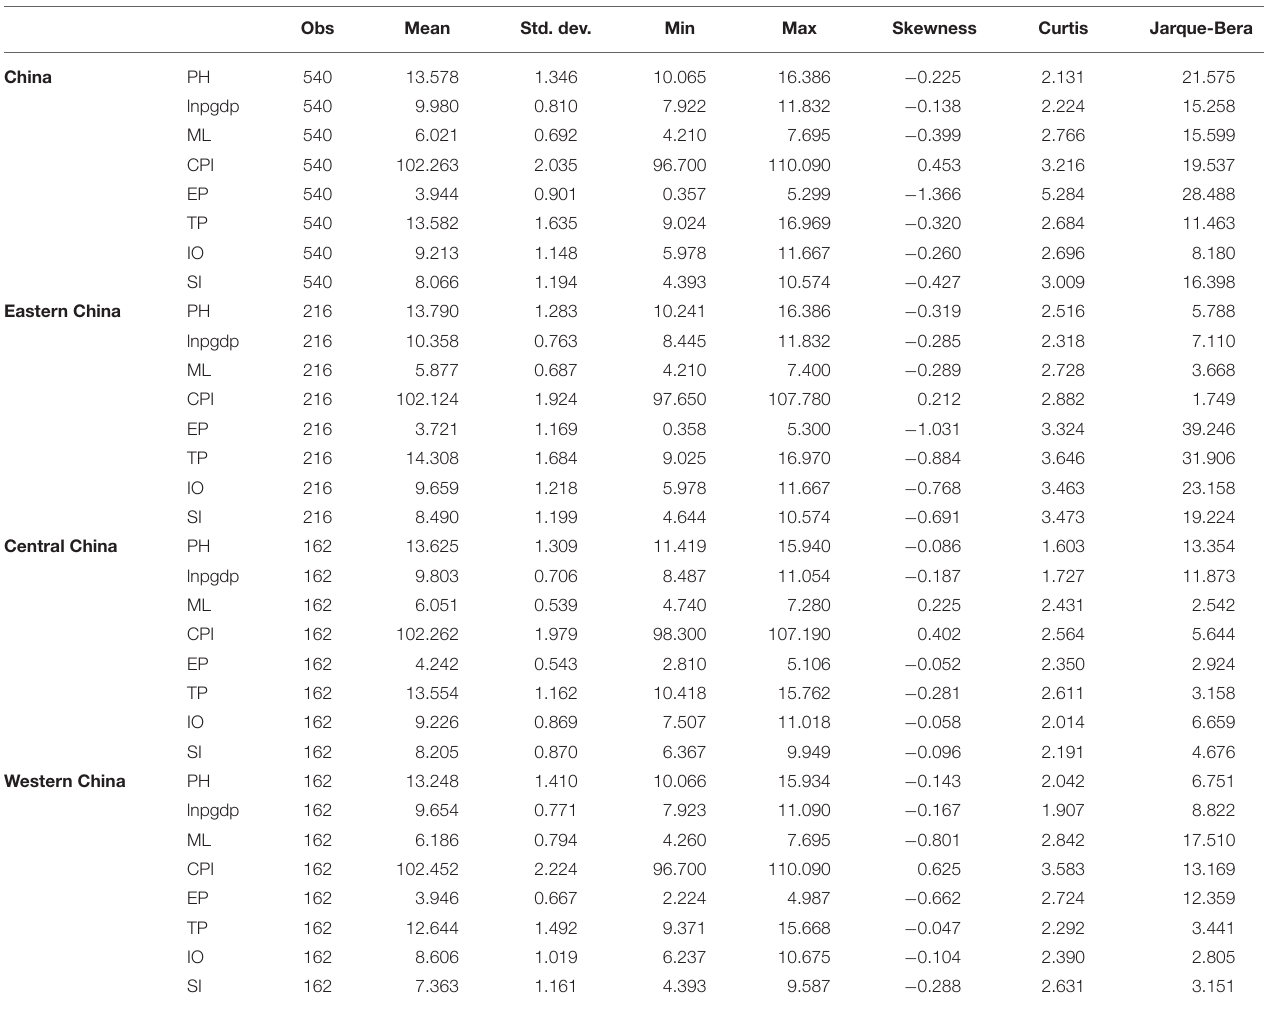
TABLE 1 | Descriptive statistics of the